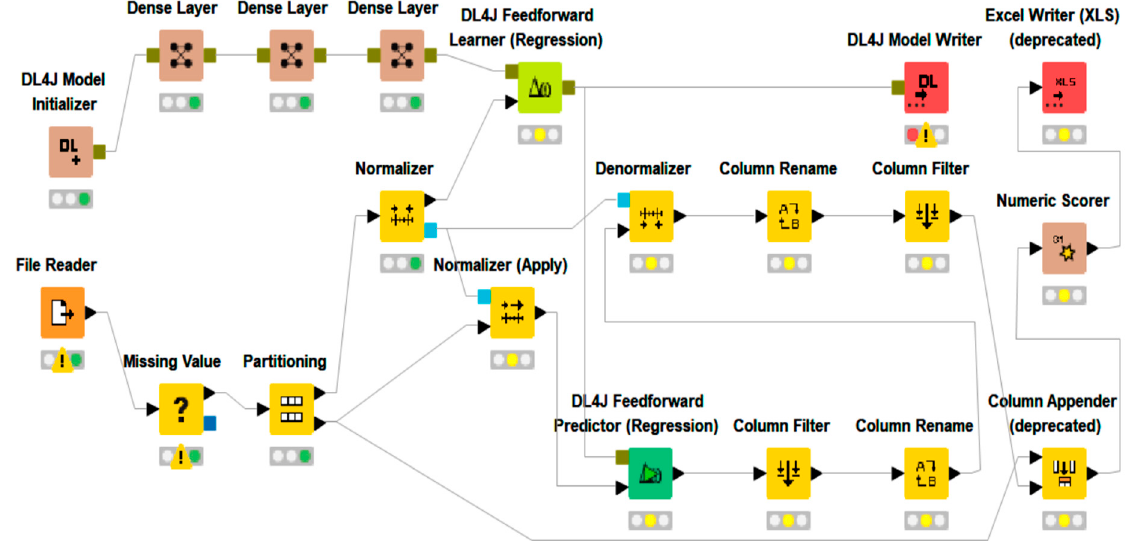
Figure 2. Deep Learning Regression